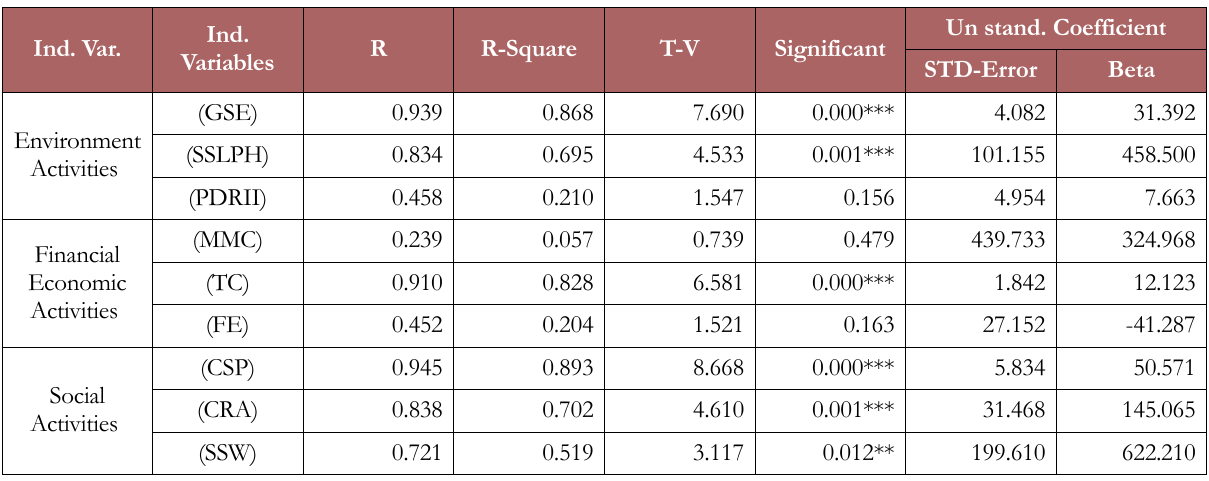
Table 1. Simple regression analysis of each green logistics activity and M2 broad money indicator as the monetary expansion indicator